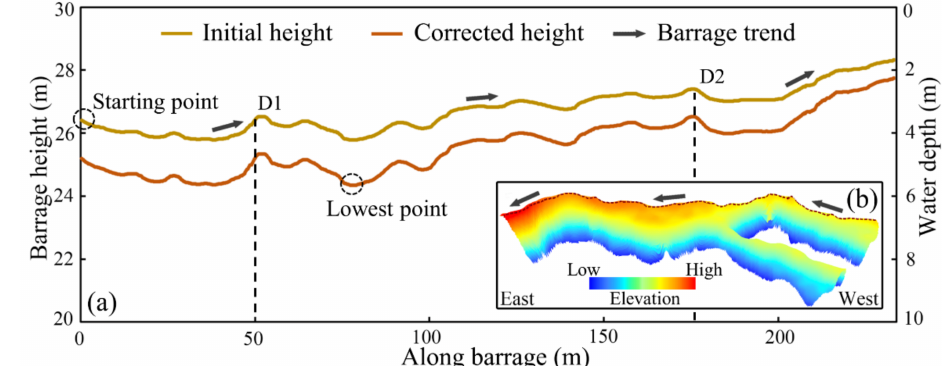
Figure 7. Refraction correction of the submerged barrage height. ( a ) Barrage crest height before and after correction, and ( b ) three-dimensional (3D) effect of the tufa barrage. The dotted line represents the location of the barrage